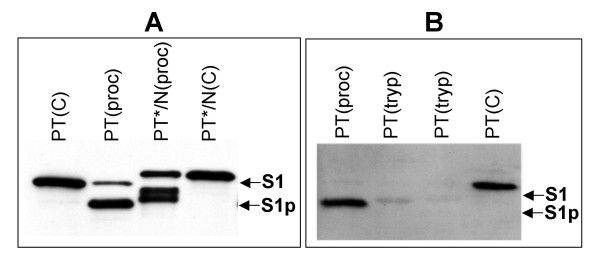
Localization of the processing site on S1. (A) CHO cells were incubated with PT or PT*-CSP/N (PT*/N) for 4 h and analyzed for S1 processing as before. Western blots are shown of the processing samples (proc) or purified protein loading controls (C). (B) Western blot comparing S1p after processing of PT in CHO cells (proc) or trypsin cleavage (tryp) of PT (200 or 100 ng).